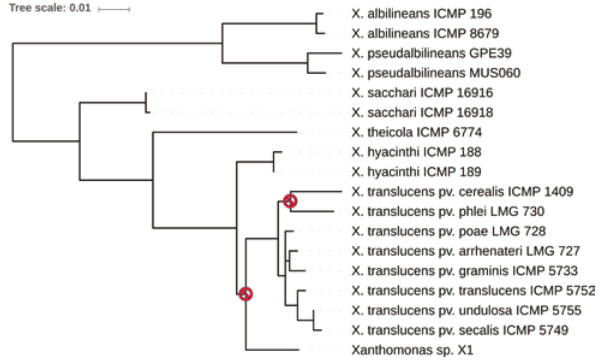
Figure 3. rpoD -based phylogenetic classification of the Algerian wheat-associated xanthomonads. Sequences were trimmed to the size of the sequences that were retrieved from PAMDB (855 bp for X. translucens and the Algerian strain). The phylogenetic tree was constructed with the Phylogeny.fr pipeline, using default param- eters, and graphically edited using the iTOL suite. All nodes were supported by bootstrap values greater than 0.75, except for those marked with a stop symbol. The scale of branch lengths is indicated at the top